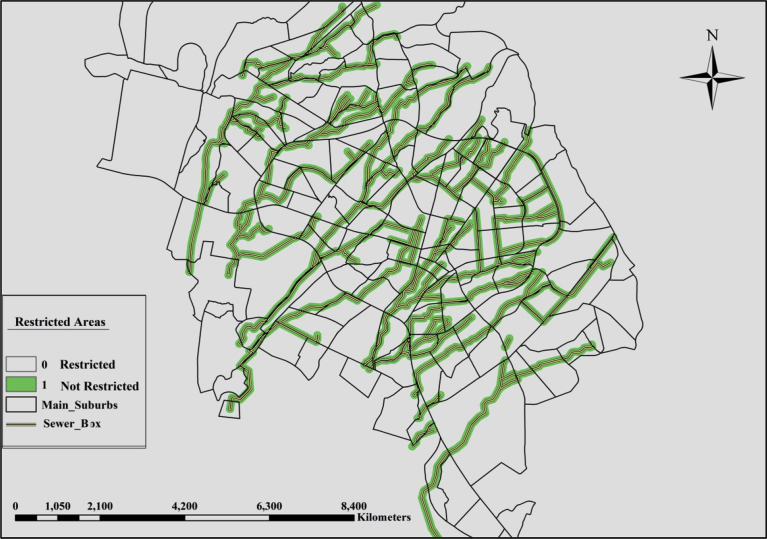
Restricted areas around the sewer box.